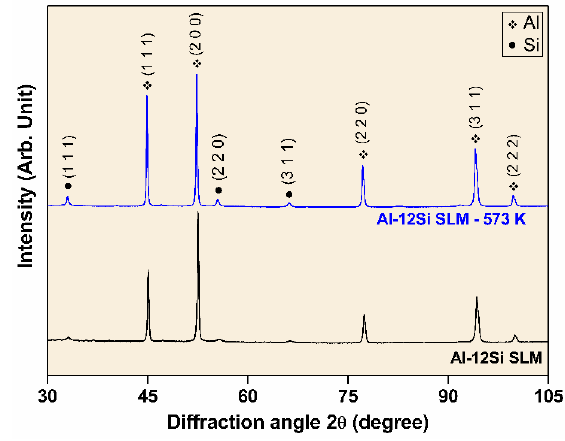
Figure 1. X -ray diffraction patterns ( λ = 0.17889 nm) for the as-prepared SLM-fabricated Al-12Si samples and samples annealed at 573 K.